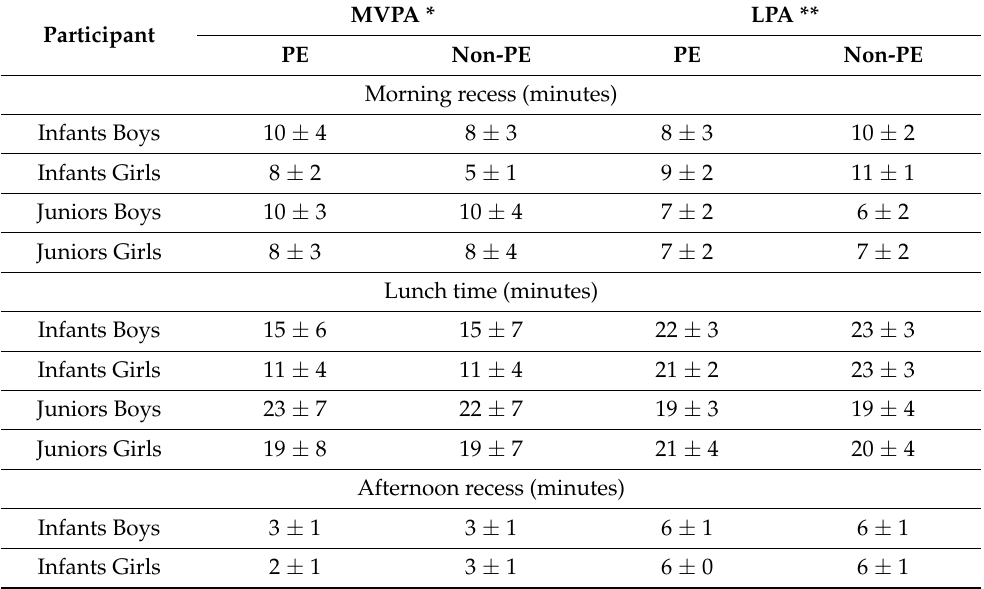
Table 2. Different physical activity intensity levels during PE and non-PE days by age and sex.